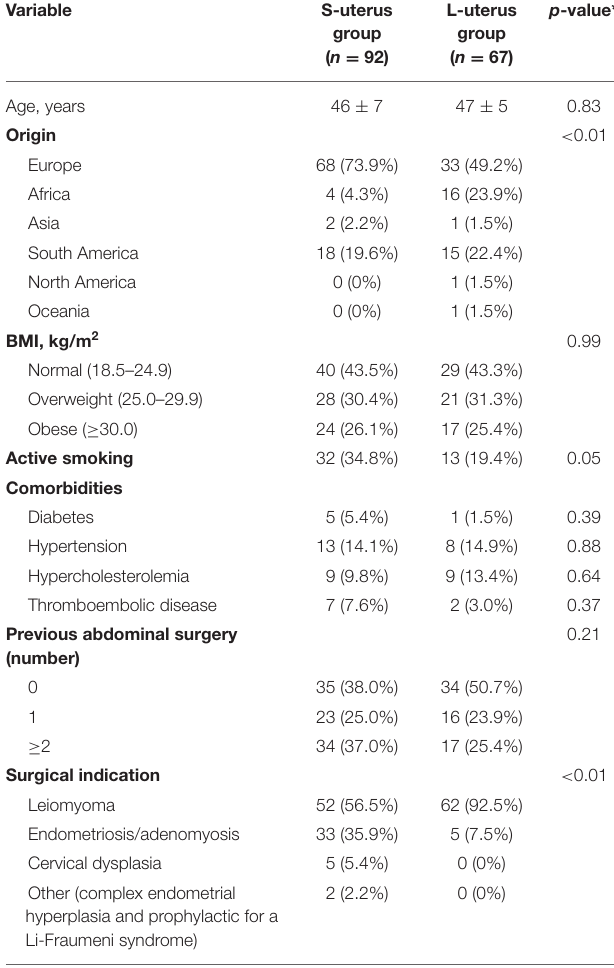
TABLE 1 | Patients’